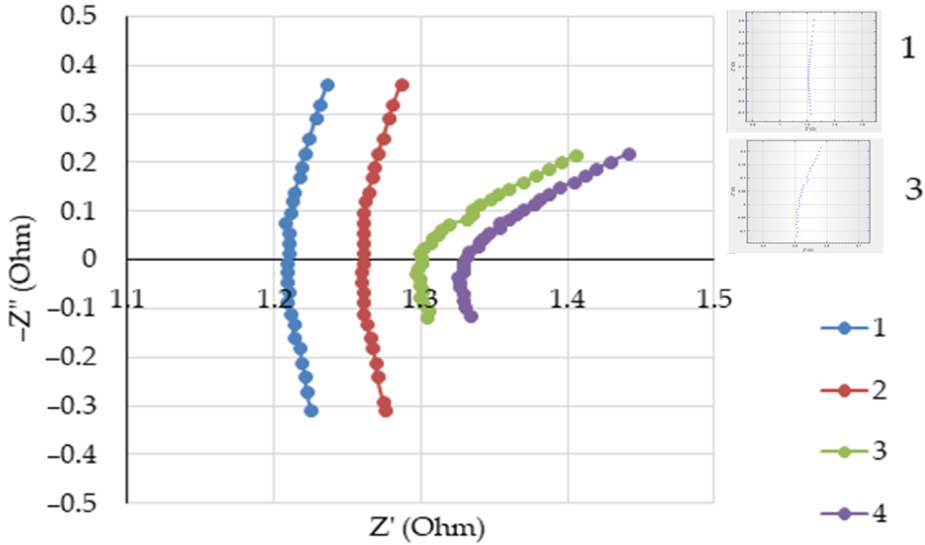
Figure 2. Nyquist plots obtained at 1273 K in the melts: 1—NaF-AlF 3 (CR = 2.3); 2—NaF-AlF 3 (CR = 2.1); 3—NaF-AlF 3 (CR = 2.1) + 2 wt% Al 2 O 3 ; 4—NaF-AlF 3 (CR = 2.1) + 4 wt% Al 2 O 3 . The Autolab original plots for melts 1 and 3 are embedded.